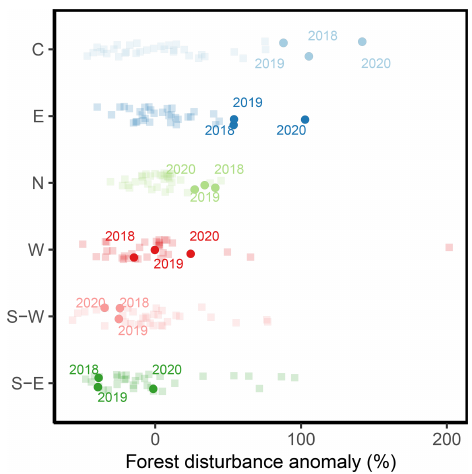
Figure 4. The development of disturbance regime characteristics in Europe’s forests in the period 1986–2020. Frequency denotes the average number of disturbances per unit forest area and year, size is the 95% quantile of the patch size distribution of disturbances, and aggregation is the average spatiotemporal autocorrelation of distur- bance patches. The drought of 2018 has pushed Europe’s forest dis- turbance regimes outside of their past basin of